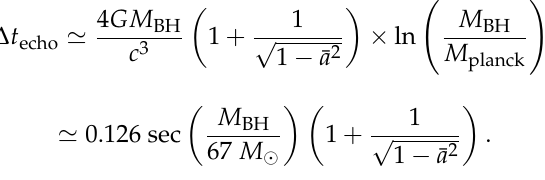
Figure 19. Average number of background peaks higher than a particular SNR-value within a time- interval 2% ∆ t echo (gray rectangle in Figures 17 and 18) for combined (left) and GW150914 (right) × events [18]. The red dots show the observed SNR peak at t echo = 1.0054 ∆ t echo (Figures 17 and 18). The correspondence between SNR values and their significance is indicated in horizontal